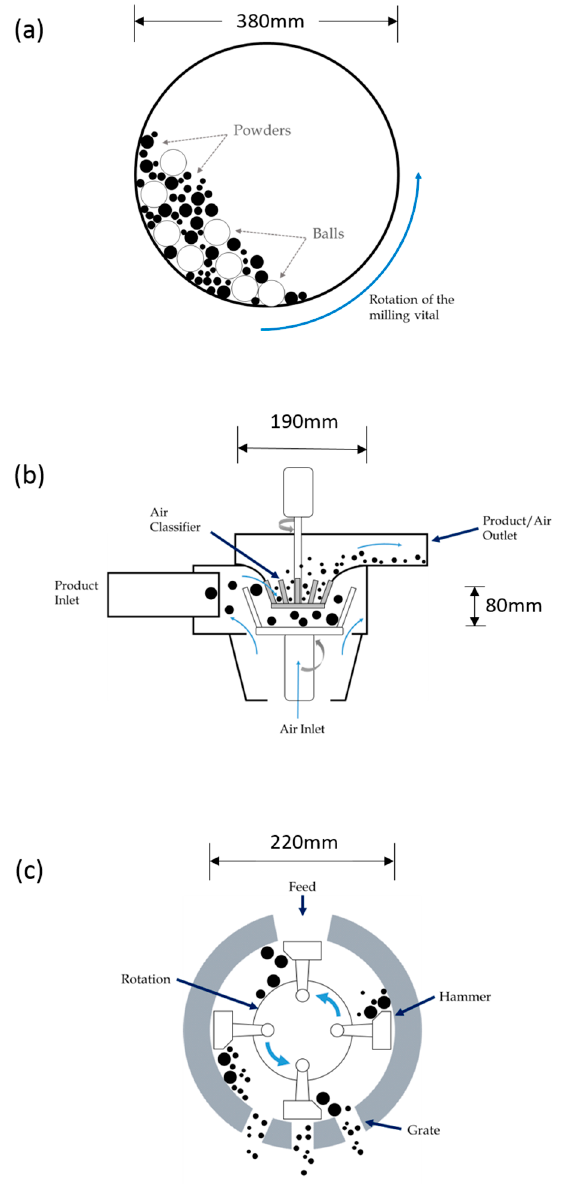
Figure 1. Schematic diagram of the three pulverizers used in this study: ( a ) A continuous ball mill (CBM); ( b ) an air classifier mill (ACM); and ( c ) a high-speed mill (HSM).